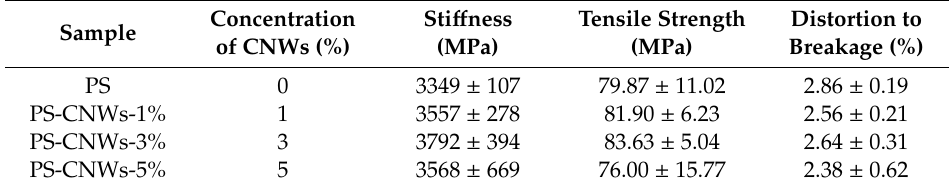
Figure 9. Stress–strain diagrams for the nanocomposite samples as well as for the pristine polymer. Table 1. Sti ff ness, strength and deformation in fracture of nanocomposites PS-CNWs with di ff erent rates of nano-additive, as well as the pristine PS, are presented the mean values and the standard deviations. Concentration Sti ff Sample of CNWs (%)